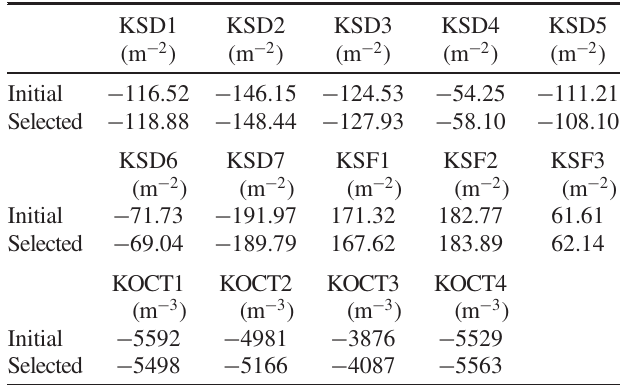
TABLE II. Comparison of the initial solution and the selected